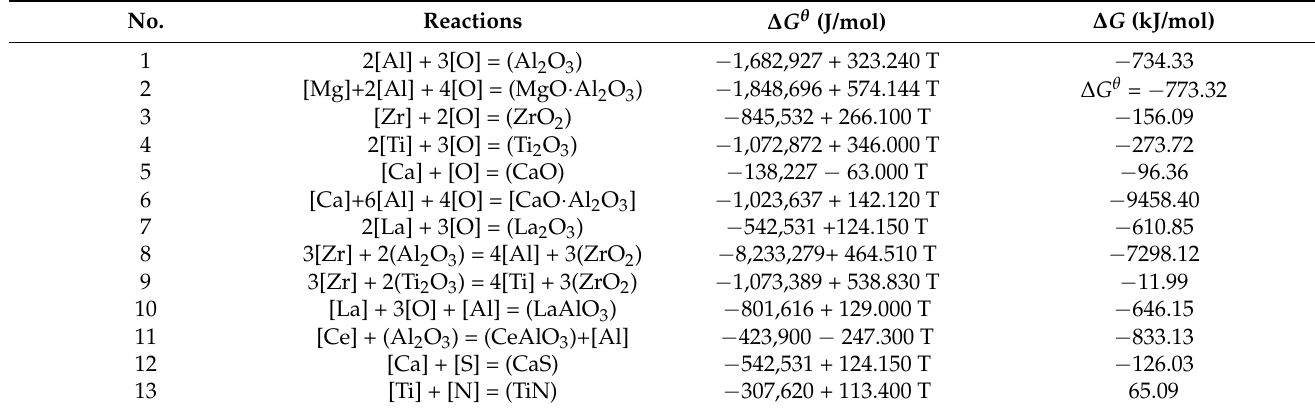
Table 2. Gibbs free energy of the inclusion formation reaction at 1873 K